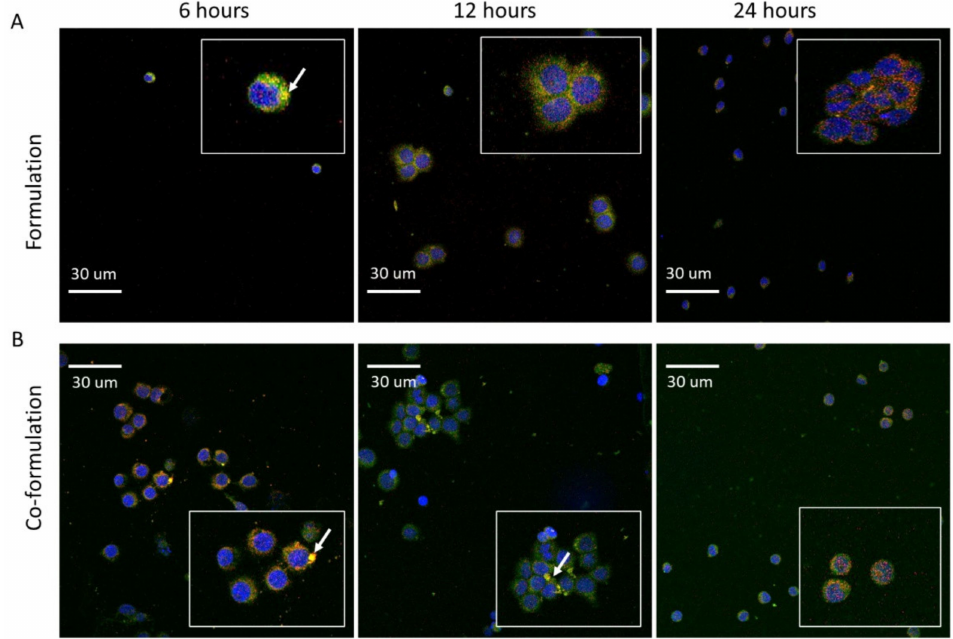
Figure 6. Confocal microscopy showing KAT2a siRNA intracellular trafficking. HL-60 cells were treated for 6, 12 and 24 h with CD-based NP formulations containing KAT2a siRNA (100 nM siRNA concentration per well). The fluorescent markers used included: FAM-labelled siRNA (green) positive cells with the lysosomes stained by LysoTracker TM Red DND-99 (red), and the nuclei (blue) by Syto TM Deep Red Nucleic Acid Stain). ( A ) Formulation, ( B ) Co-formulation. Magnification 40 ×